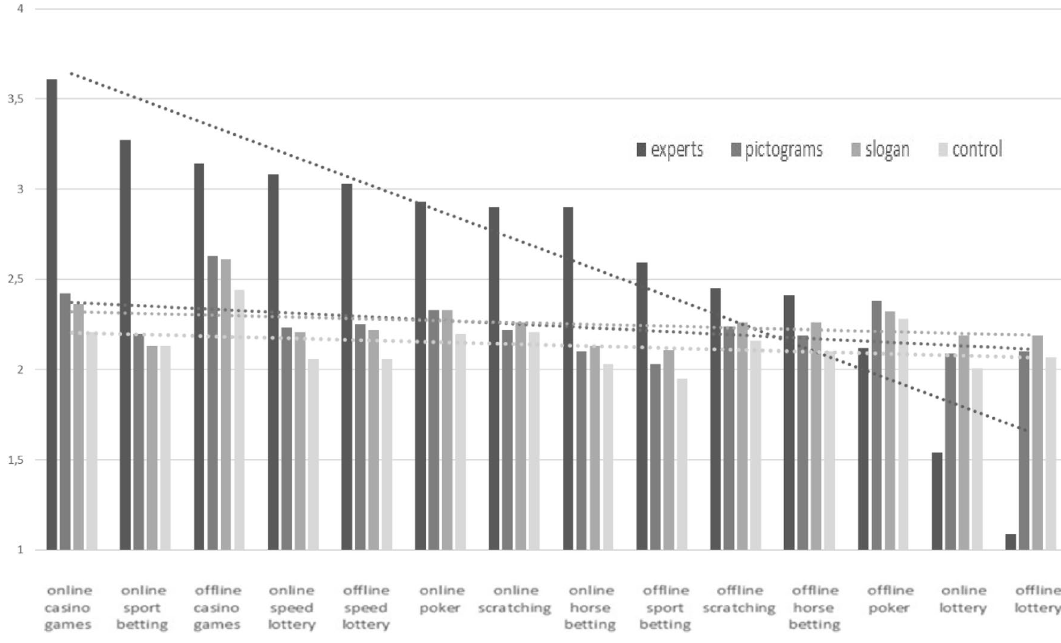
Figure 3. Mean addictiveness of gambling products, standard deviation and linear mean curve, as rated by the three groups (n = 900) and by French experts (n = 25) (Likert-scale 0 to